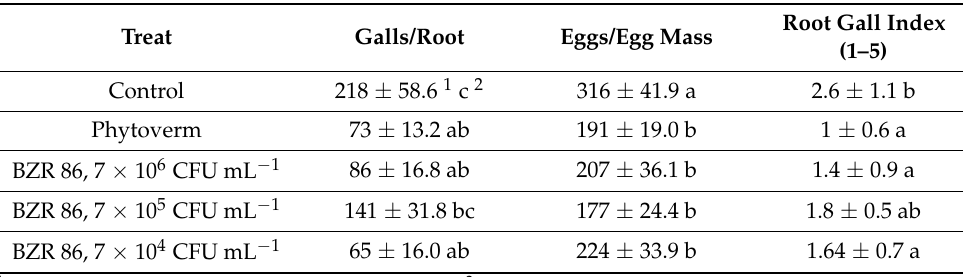
Table 3. Influence of Bacillus velezensis BZR 86 on the development of root-knot disease of cucumber (cv. Kurazh).